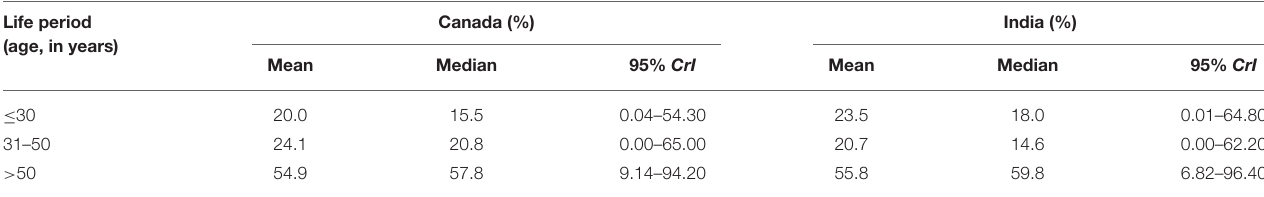
TABLE 2 | The relative importance of smoked tobacco exposure at different life periods for the risk of developing HPV − negative oral cavity cancer (OCC), HeNCe Life study Canadian and Indian sites. Life period (age, in